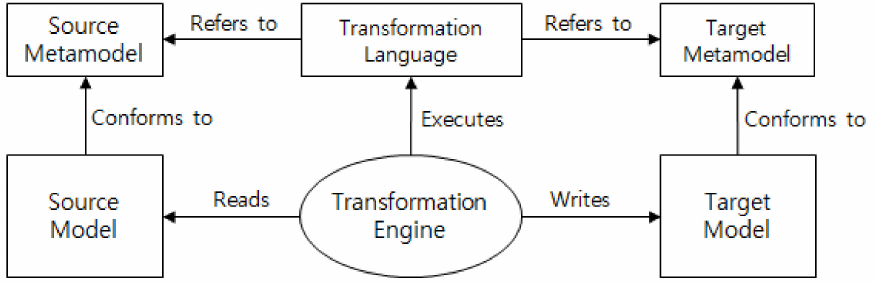
Figure 1. Structure of metamodel-based model transformation engine.